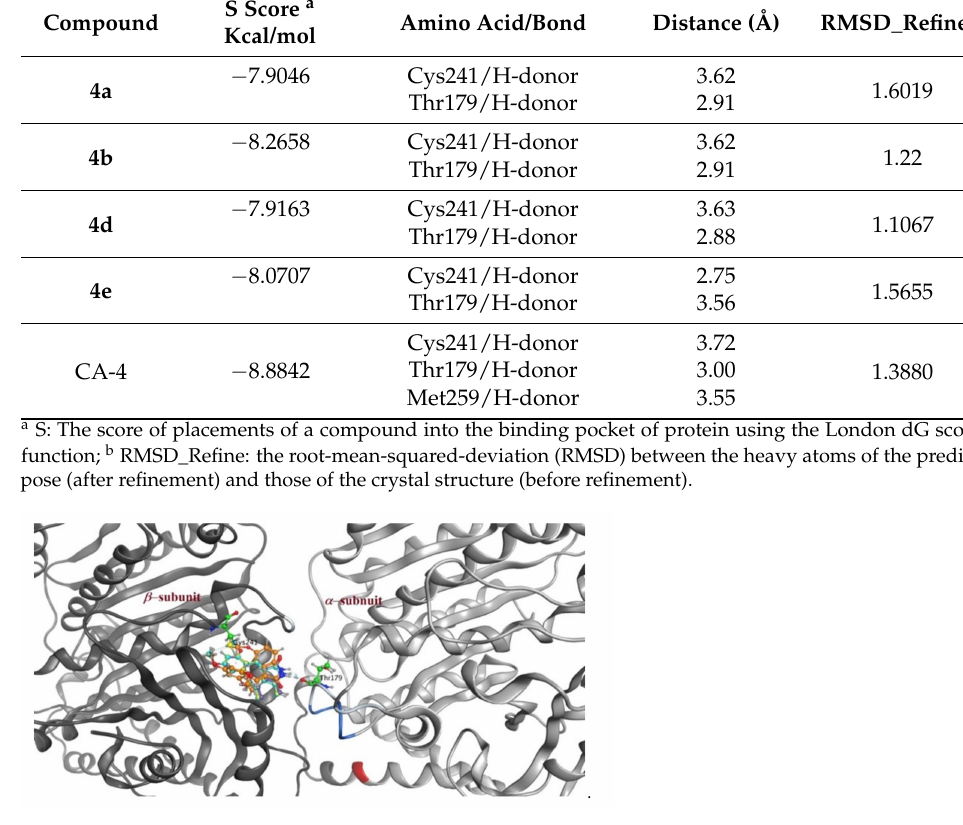
Figure 11. Presumptive binding mode of compound 4a (yellow), compound 4b (cyan), compound 4d (magenta), and compound 4e (brown). Cys241 is shown on the left and Thr179 is shown on the right. All the docked compounds, key amino acids Cys241 and Thr179 are in stick